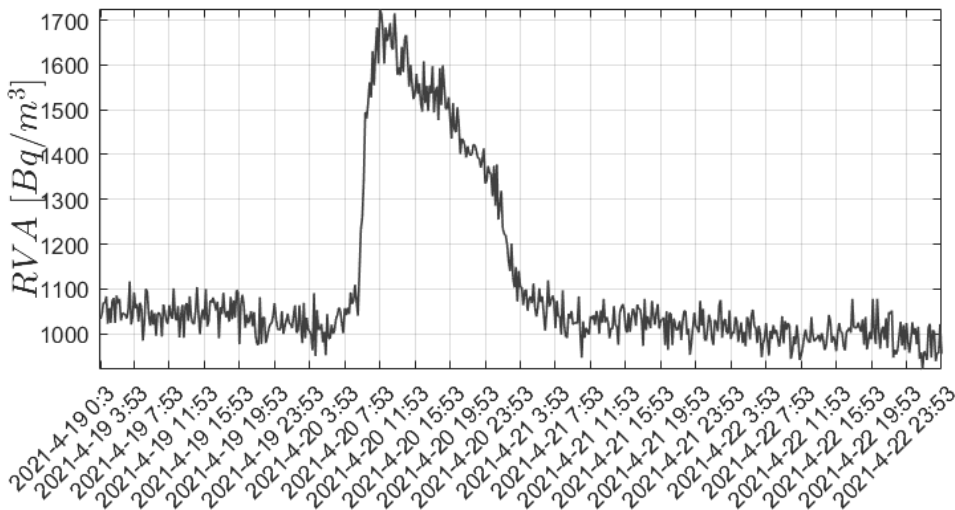
Figure 6. Observation data from the MRZR observation